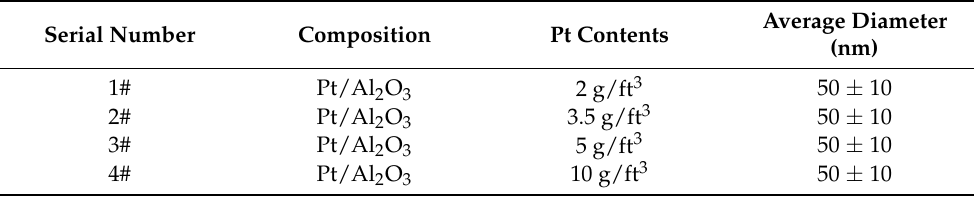
Table 2. Main parameters of catalysts.